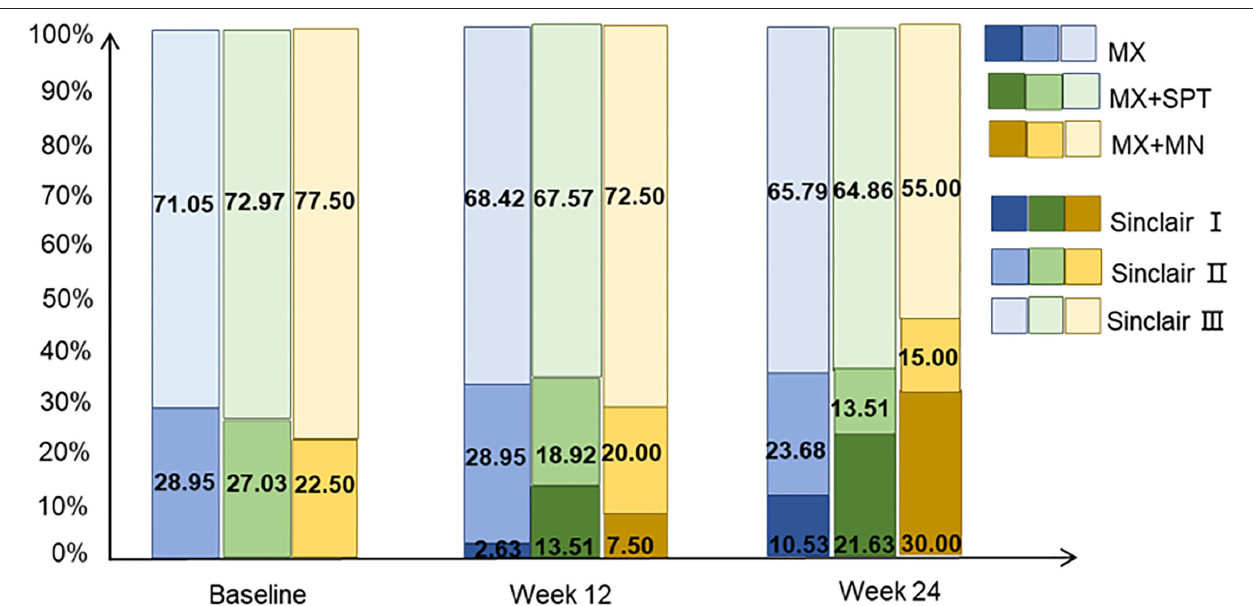
FIGURE 6 | The distribution of Sinclair stage of the patients treated with minoxidil, minoxidil plus spironolactone, and minoxidil plus microneedling.